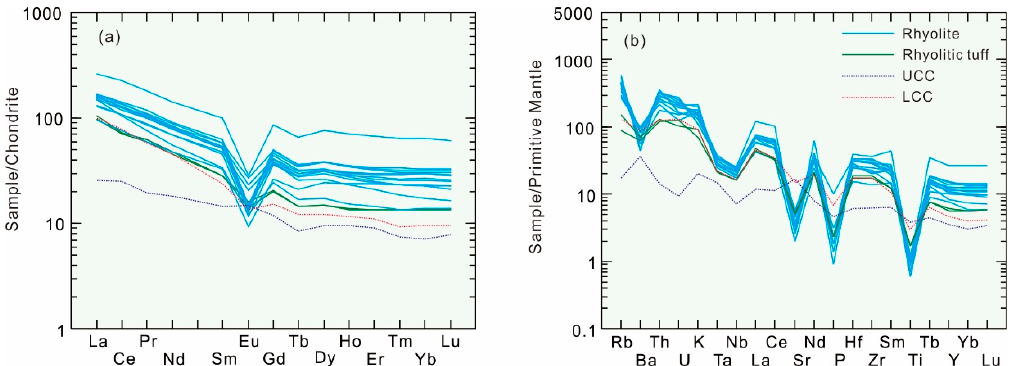
Figure 7. ( a ) Chondrite-normalized REE patterns and ( b ) primitive mantle-normalized trace element patterns of the Early Devonian volcanic rocks from Haerdaban area in the northern margin of Yili Block. Normalizing values are from [50]. Values of the upper continental crust (UCC) and lower continental crust (LCC) are from [51].